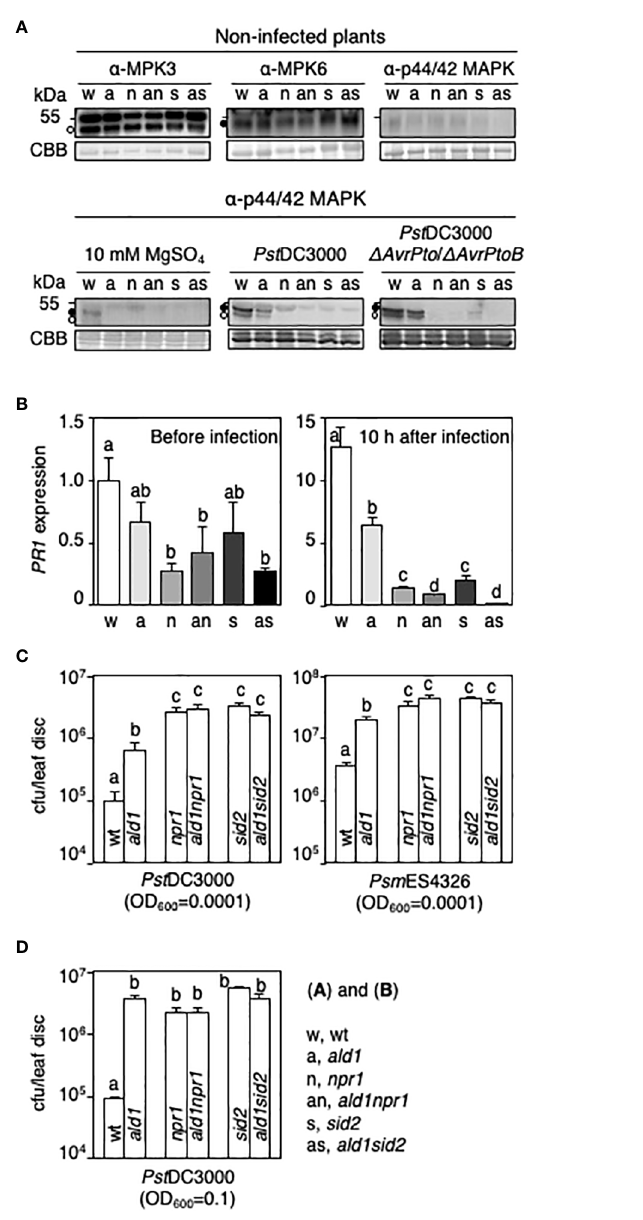
FIGURE 1 Loss of ALD1 in npr1 or sid2 mutants does not alter the susceptibility of Arabidopsis against infection by virulent strains of Pseudomonas . (A) Levels of MPK3, MPK6, and phosphorylated MPK3 and MPK6 in leaves of WT (w), ald1 (a), npr1 (n), ald1npr1 (an), sid2 (s), and ald1sid2 (as) without (upper panel) and with pathogen infection (lower panel). Open circles and fi lled circles point out MPK3 and MPK6, respectively. Membranes were stained with Coomassie Brilliant Blue R-250 (CBB) to verify equal loading. Infected leaves with 10 mM MgSO4, Pst DC3000, or Pst DC3000 AvrPto / AvrPtoB (OD 600 = 0.01) were taken 30 min after in fi ltration. (B) Relative PR1 mRNA level in leaves of WT and mutants during Psm ES4326 infection (OD 600 = 0.01). mRNA level in the non-infected WT plant ( PR1 / ACTIN2 ) was set to 1, and then mRNA levels of each condition were normalized by the value of the non-infected WT plant. Error bars represent the standard deviation from three biological replicates (number of technical replicates = 3). (C) Growth of virulent strains of Pseudomonas in Arabidopsis plants 3 days after syringe- inoculation. Leaves of 24- to 28-day-old plants were inoculated with either a virulent strain of Pst DC3000 (left panel) or Psm ES4326 (right panel) (OD 600 = 0.0001) by using a needleless syringe. (D) Growth of Pst DC3000 in leaves of Arabidopsis plants 5 days after spray-inoculation (OD 600 = 0.1). Error bars indicate standard error (n = 8 for syringe-inoculation; n = 12 for spray-inoculation) (C, D) . The experiments were repeated more than three times with the same results. Different letters above bars indicate statistically signi fi cant differences ( p < 0.05, one-way ANOVA) (B-D)